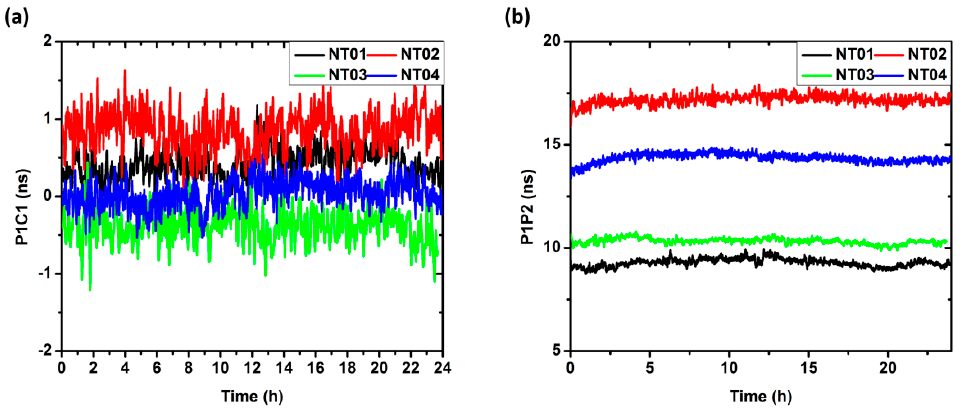
Figure 7. The DCB time series of ( a ) P1C1 and ( b ) P1P2 for the four selected stations.